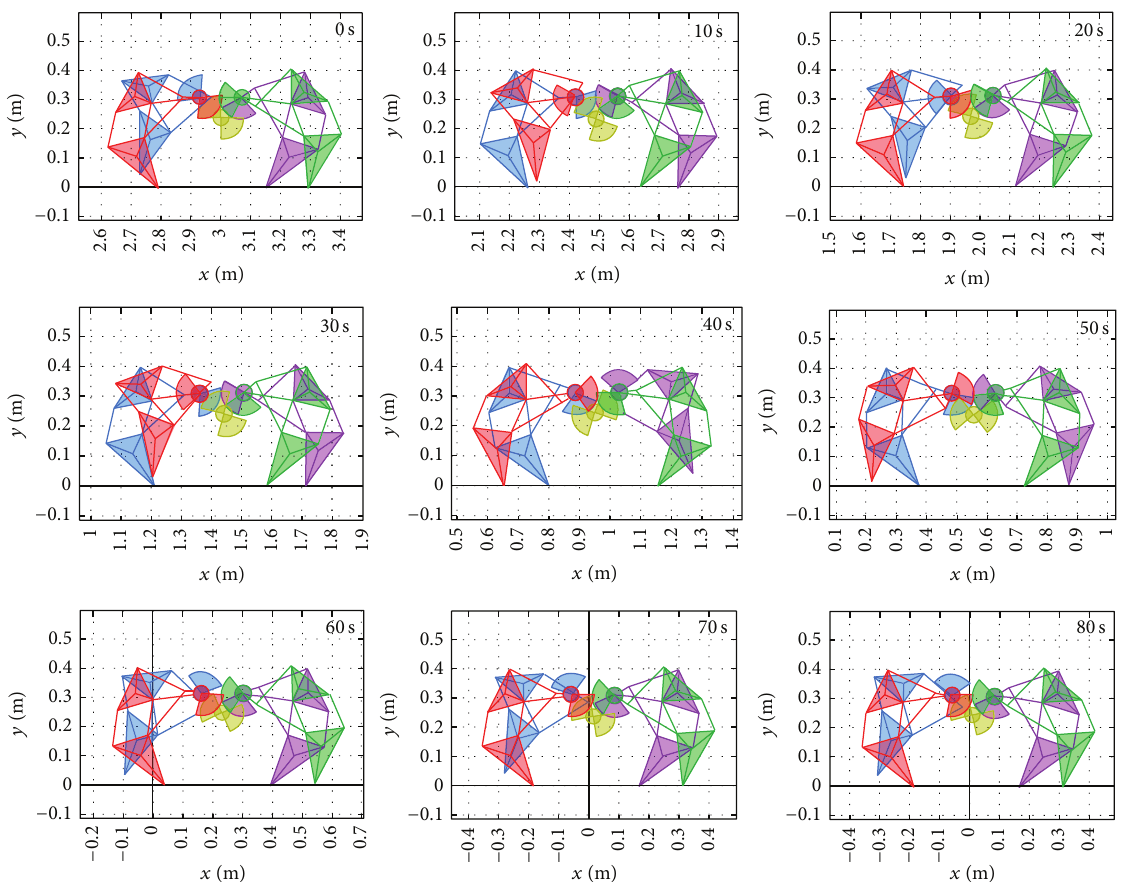
Figure 13: The snapshots of walking towards the target position based on the energy-based position